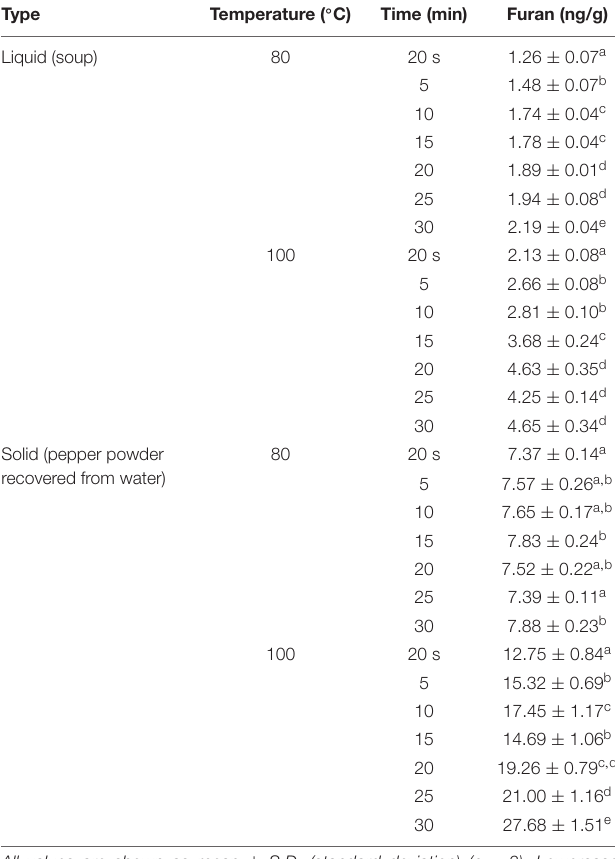
TABLE 1 | Furan concentration of boiled red pepper and soup samples.